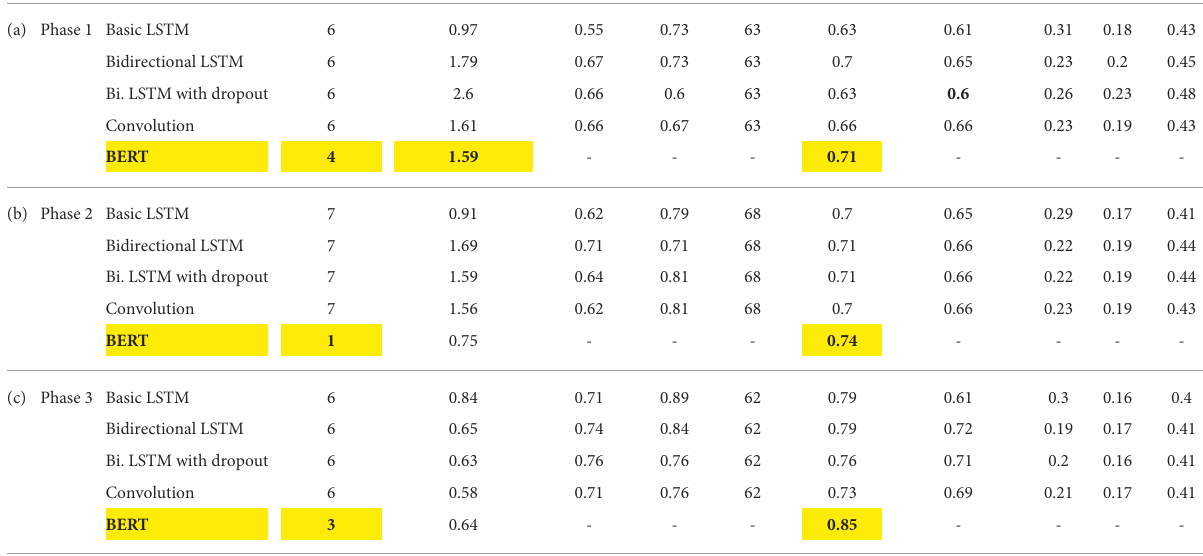
TABLE 3 The performance of deep learning methods for different phases. Model